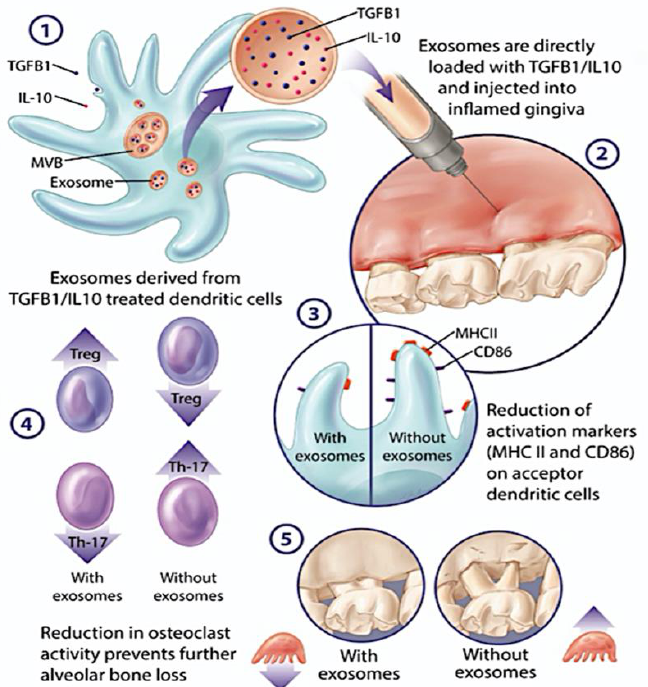
Figure 1. DC Exosome (Exo) Therapy for the Inflammatory Bone Disease Periodontitis. 1. TGFb-/IL-